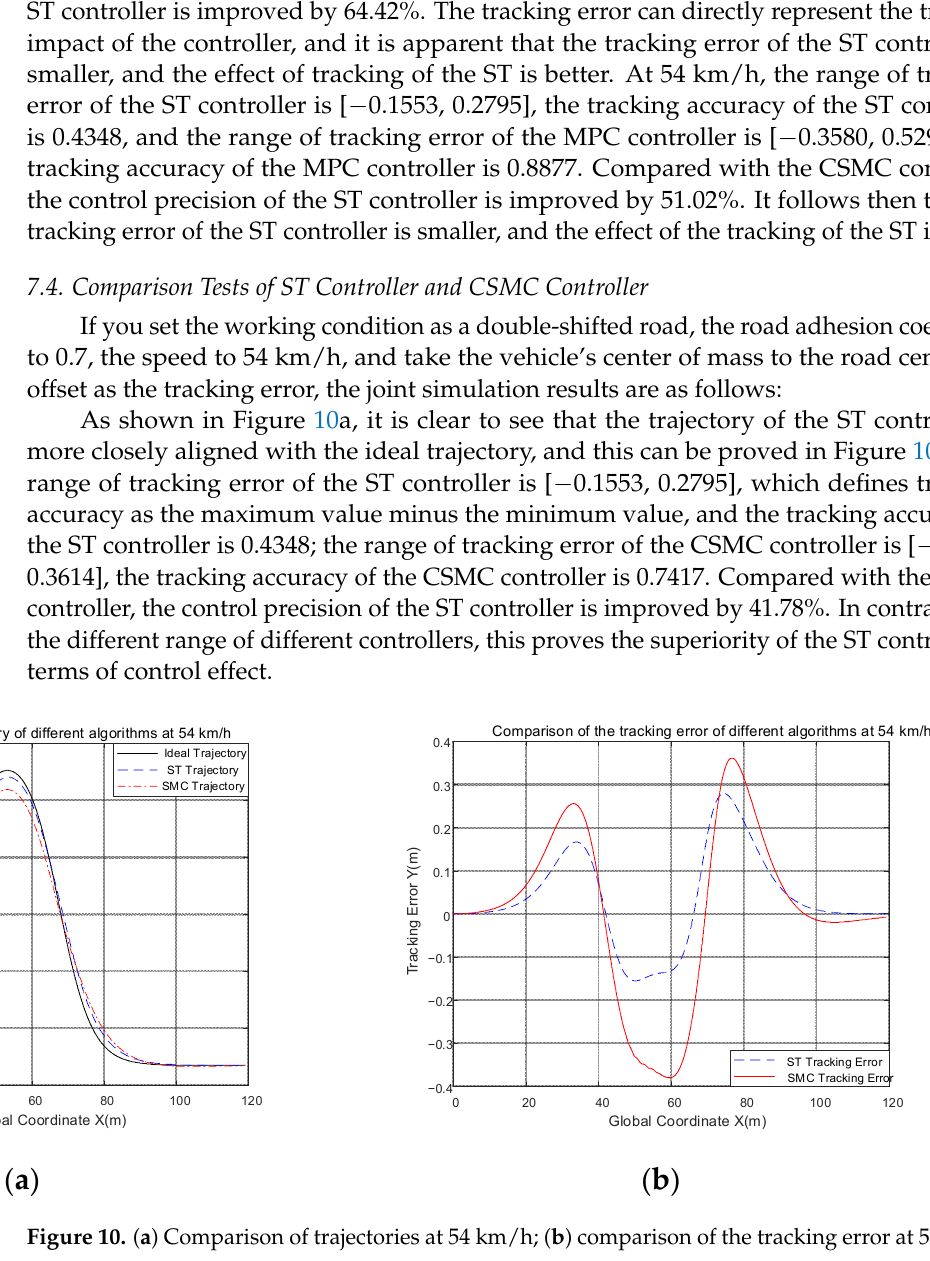
Comparison of steering wheel angles of different algorithms at 54 km/h ST Steering Wheel Angle without filtering ST Steering Wheel Angle with filtering CSMC Steering Wheel Angle